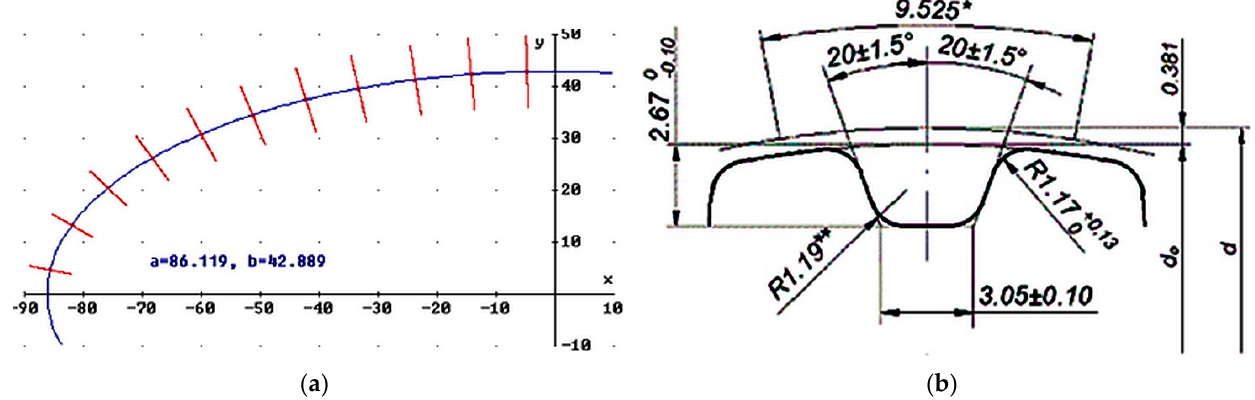
Figure 2. Elliptical wheel: outline of a wheel with the normal positions plotted at the points defining the tooth gaps (mm) ( a ), the outline of a wheel groove for a scale type L (mm) ( b ) .